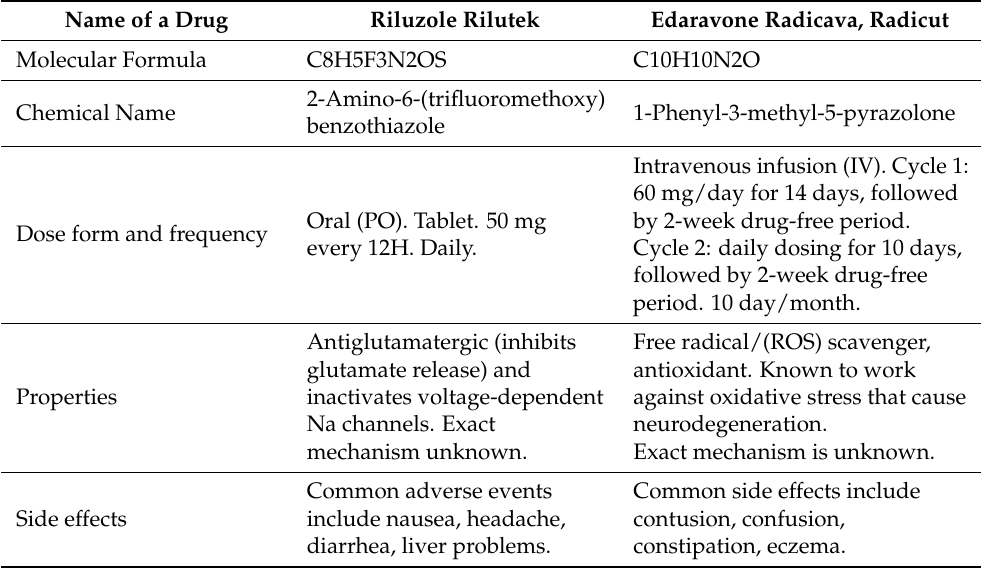
Table 2. Simple comparison between riluzole and